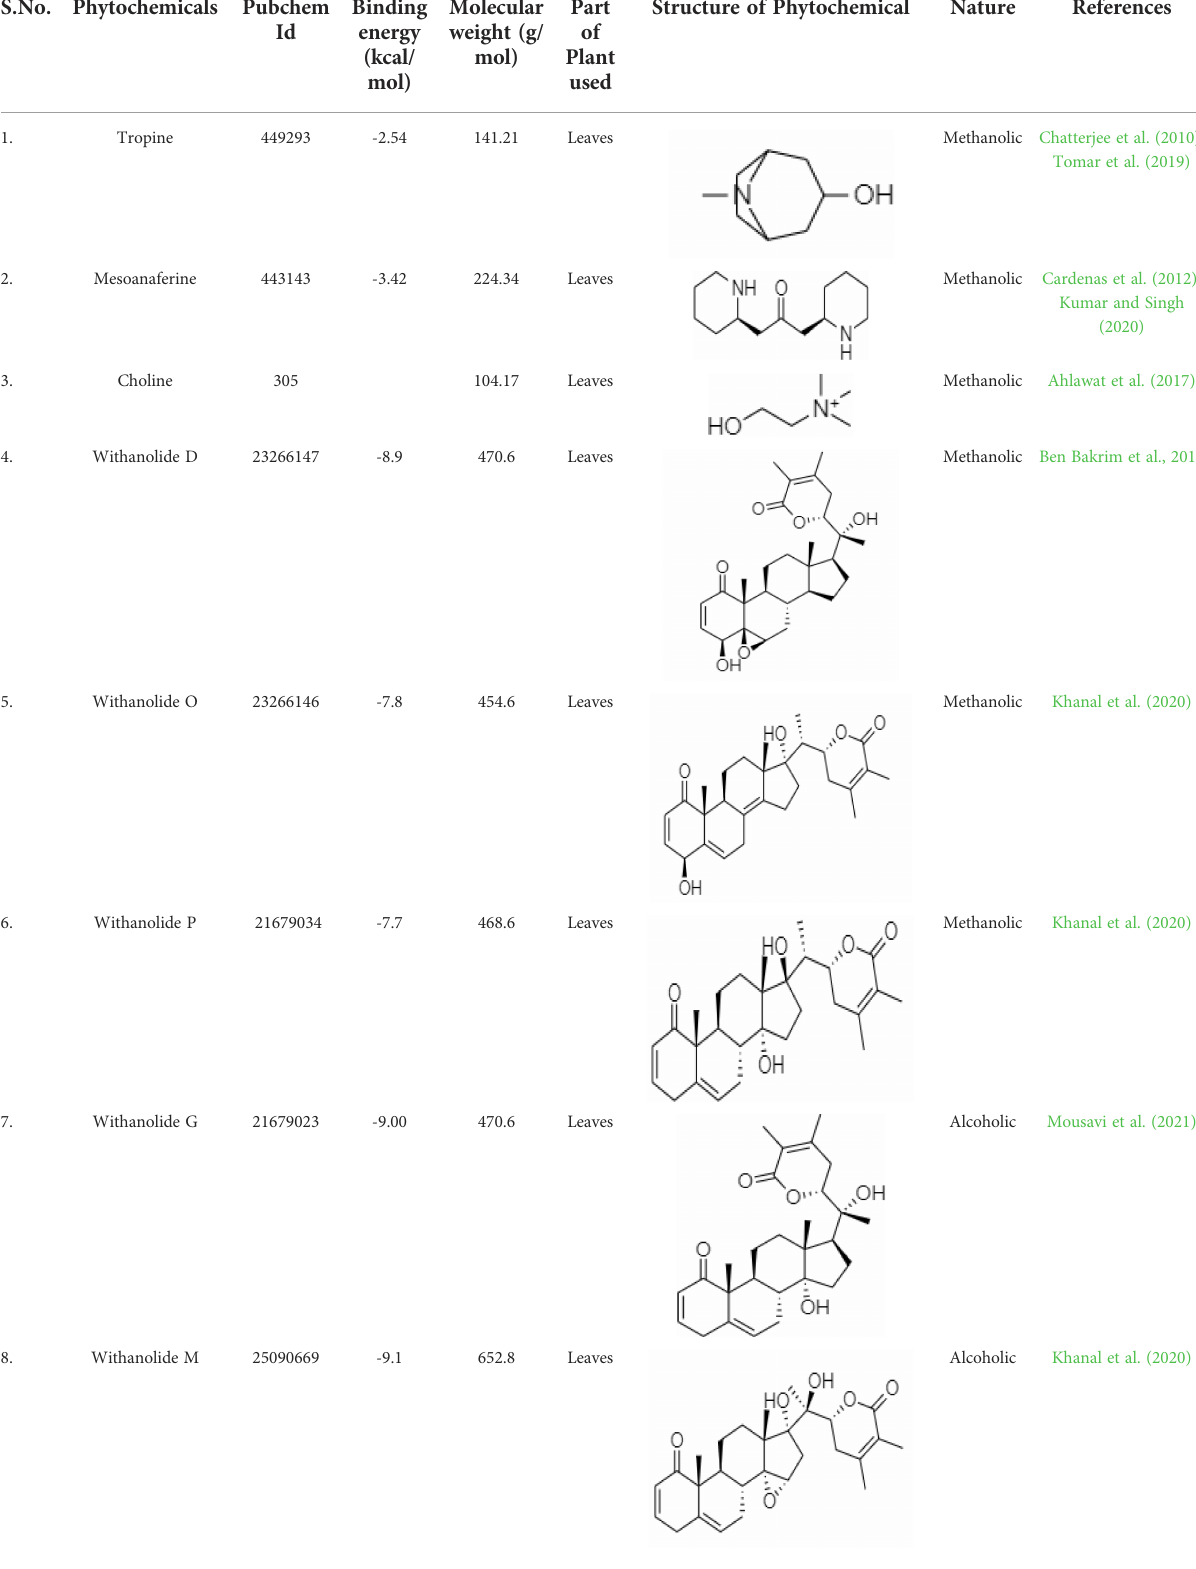
TABLE 2 Important bioactive metabolites extracted from Withania somnifera may be used for the management of